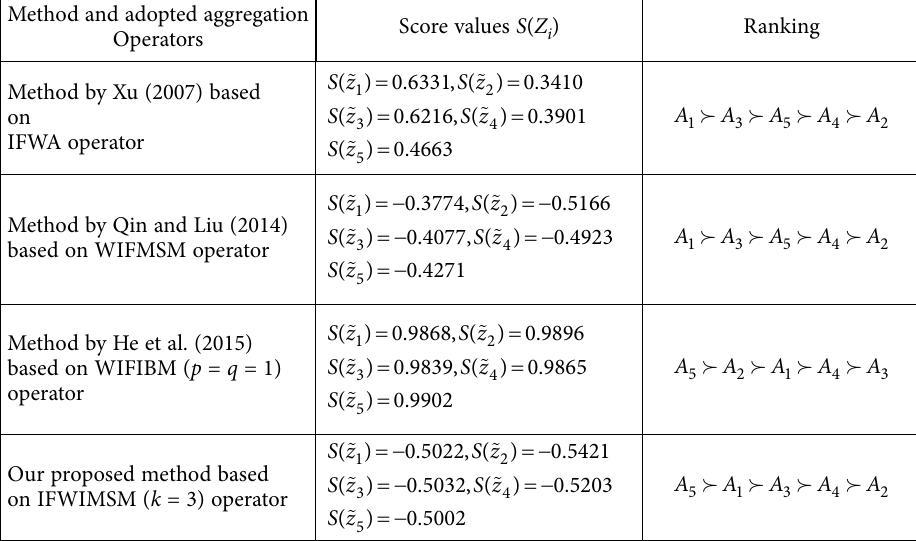
Table 8. Ranking results by different methods Method and adopted aggregation